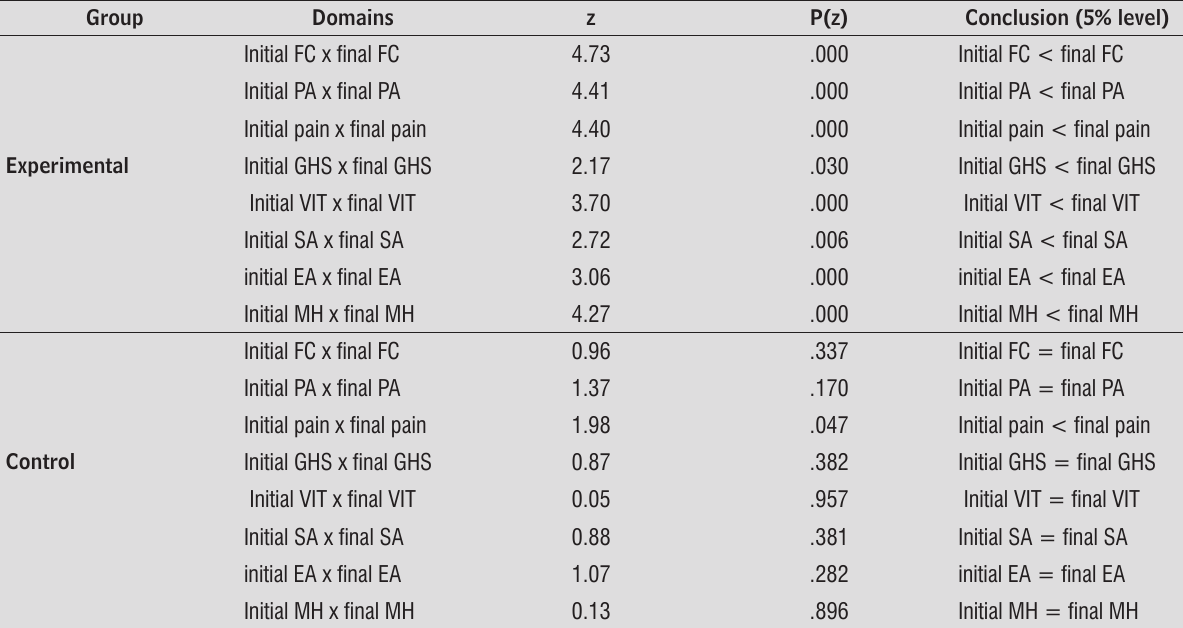
Table 4 - Comparison between the two measurements in each domain of the SF-36, in the two groups, through the Wilcoxon test, Ribeirão Preto-SP,